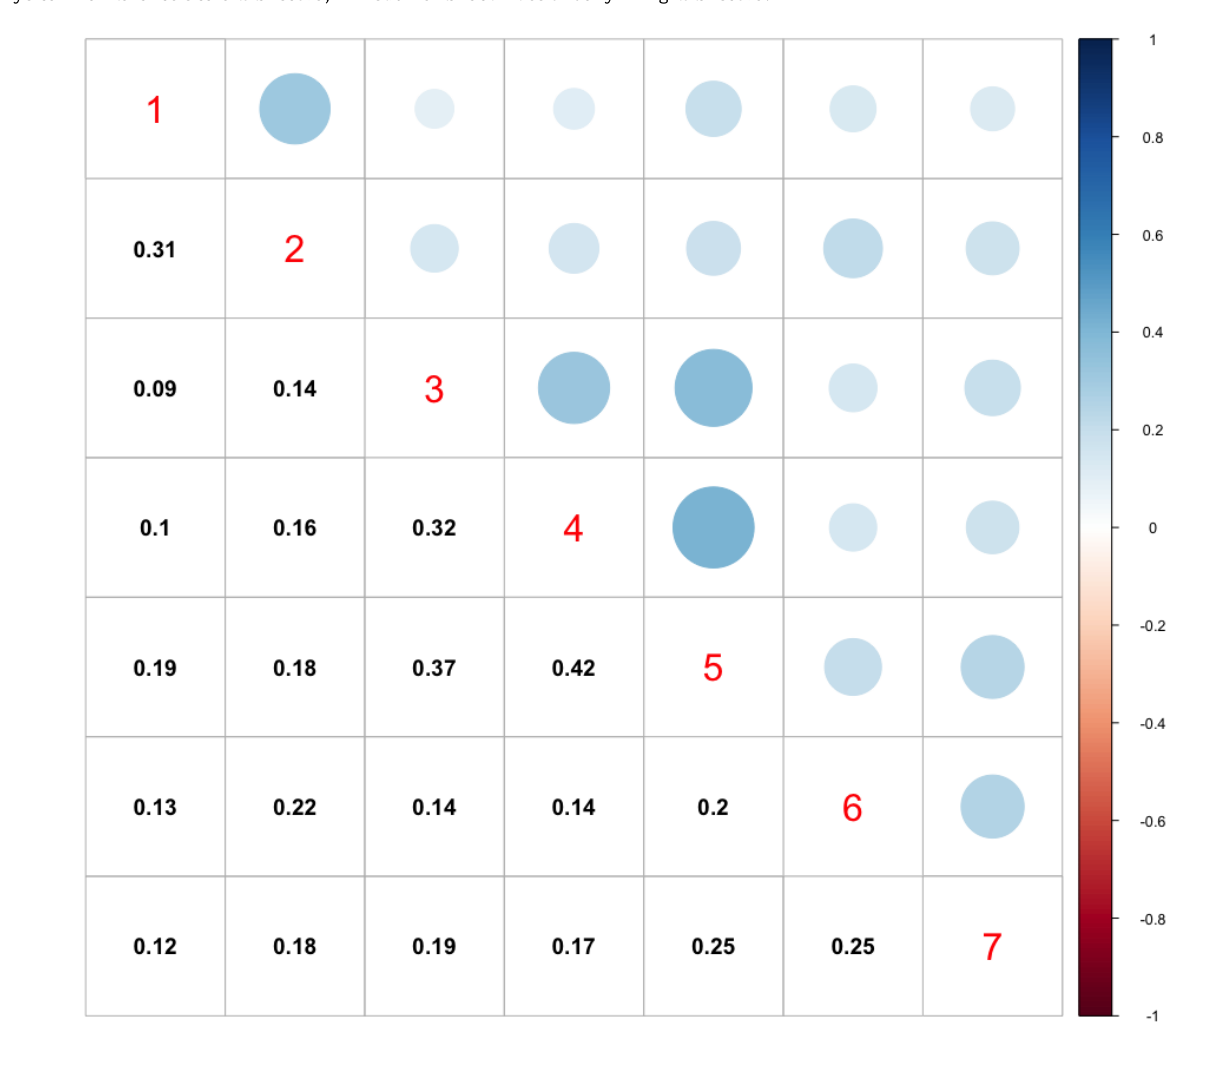
Figure 6. Correlation matrix using the Spearman (nonparametric) coefficient between participant test scores, ignoring observations with missing data. Variable descriptors are as follows: 1=Hospital Anxiety and Depression Scale total score; 2=depression questionnaire total score; 3=Mini-Mental State Examination total score; 4=Frontal Assessment Battery total score; 5=Repeatable Battery for the Assessment of Neuropsychological Status total score; 6=Physical Maintenance Scale total score; 7=instrumental activities of daily living total